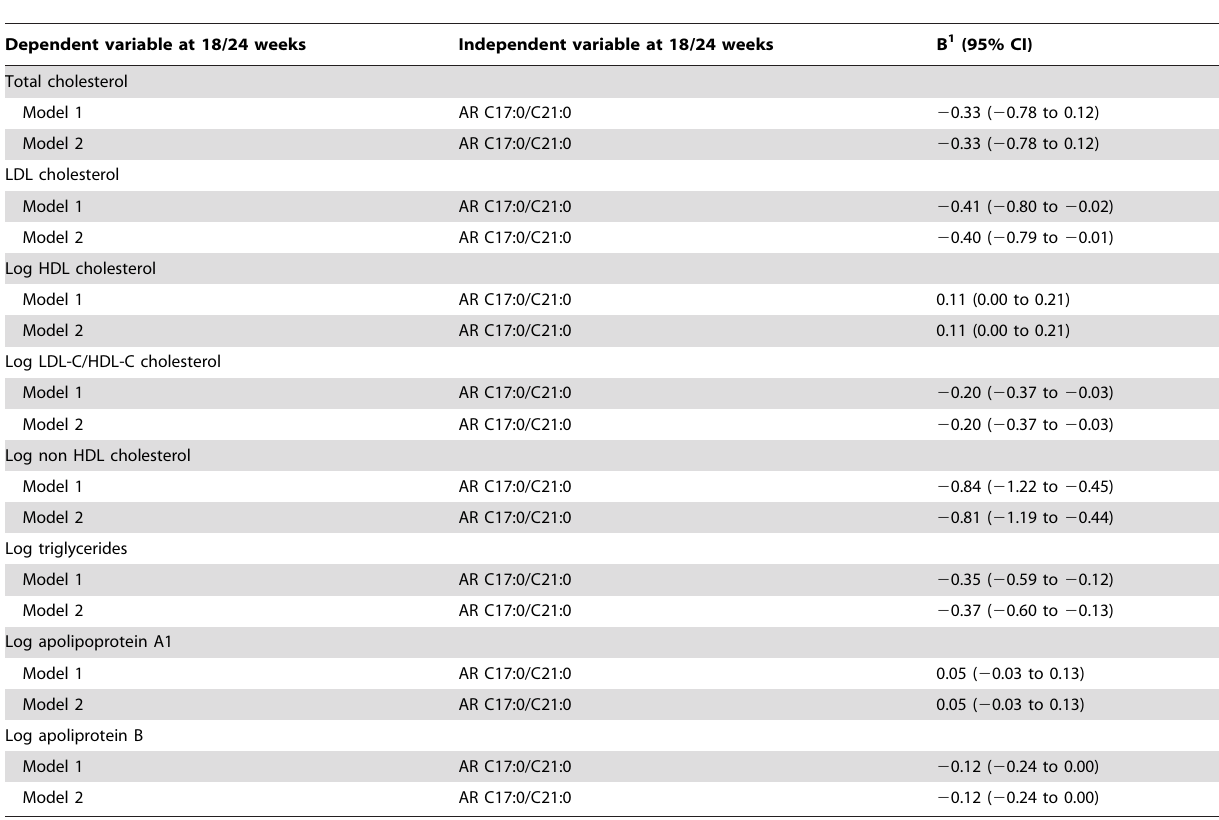
Table 3. Regression models for concentrations of serum total, HDL, LDL, non HDL cholesterol and triglycerides and the cholesterol LDL-C/HDL-C